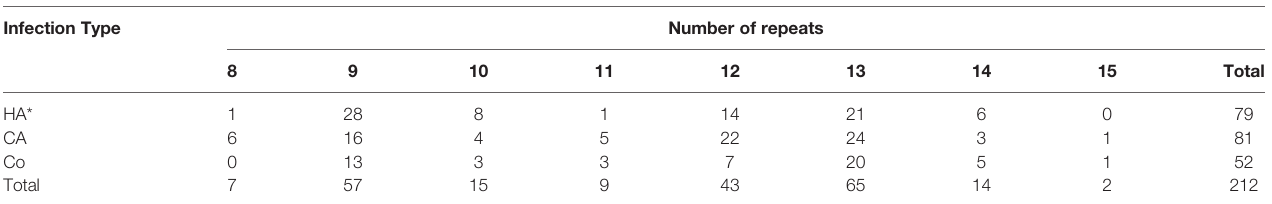
Frontiers in Cellular and Infection Microbiology |